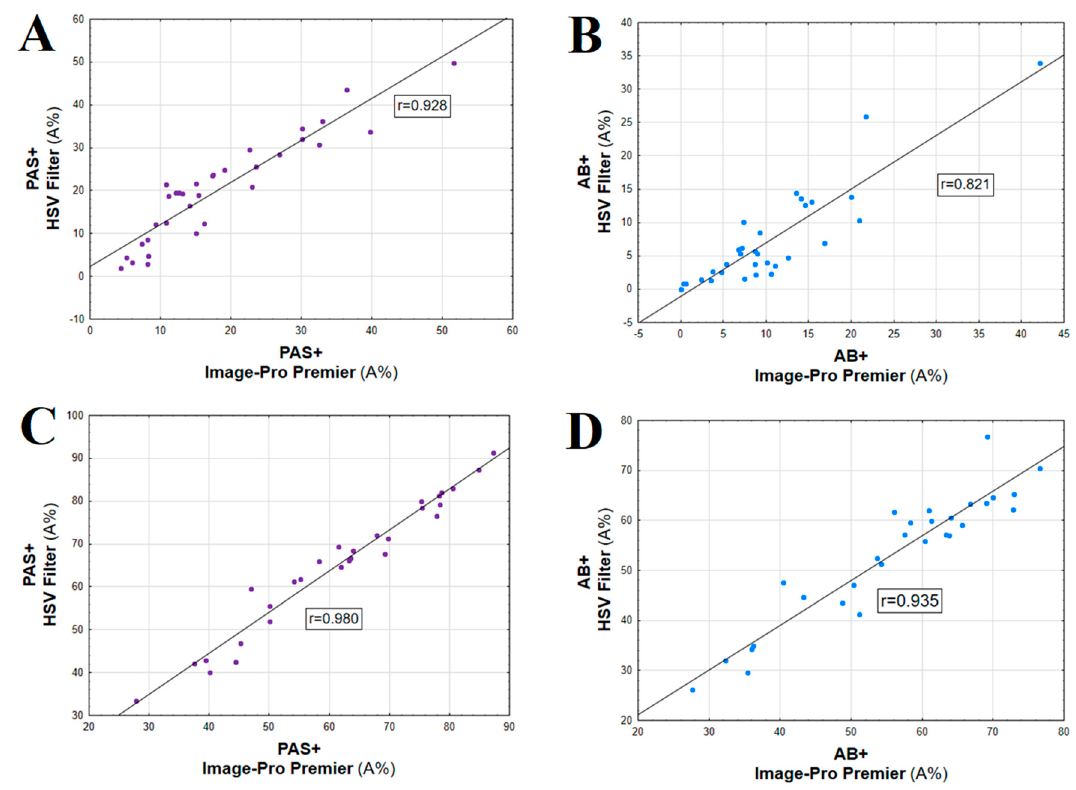
Figure 2. Correlation between two types of computerized methods used for quantitative evaluation of PAS + and AB + expression in colorectal carcinoma ( A and B ) and unaltered colorectal tissue samples (control) ( C and D ) ( p < 0.05 in all cases). Table 2. Tissue expression of polysaccharides of both PAS + and AB + mucins in colorectal carcinoma (CRC) and in unaltered colorectal samples (control) evaluated by semi-quantitative score (IRS) and two types of digital software.